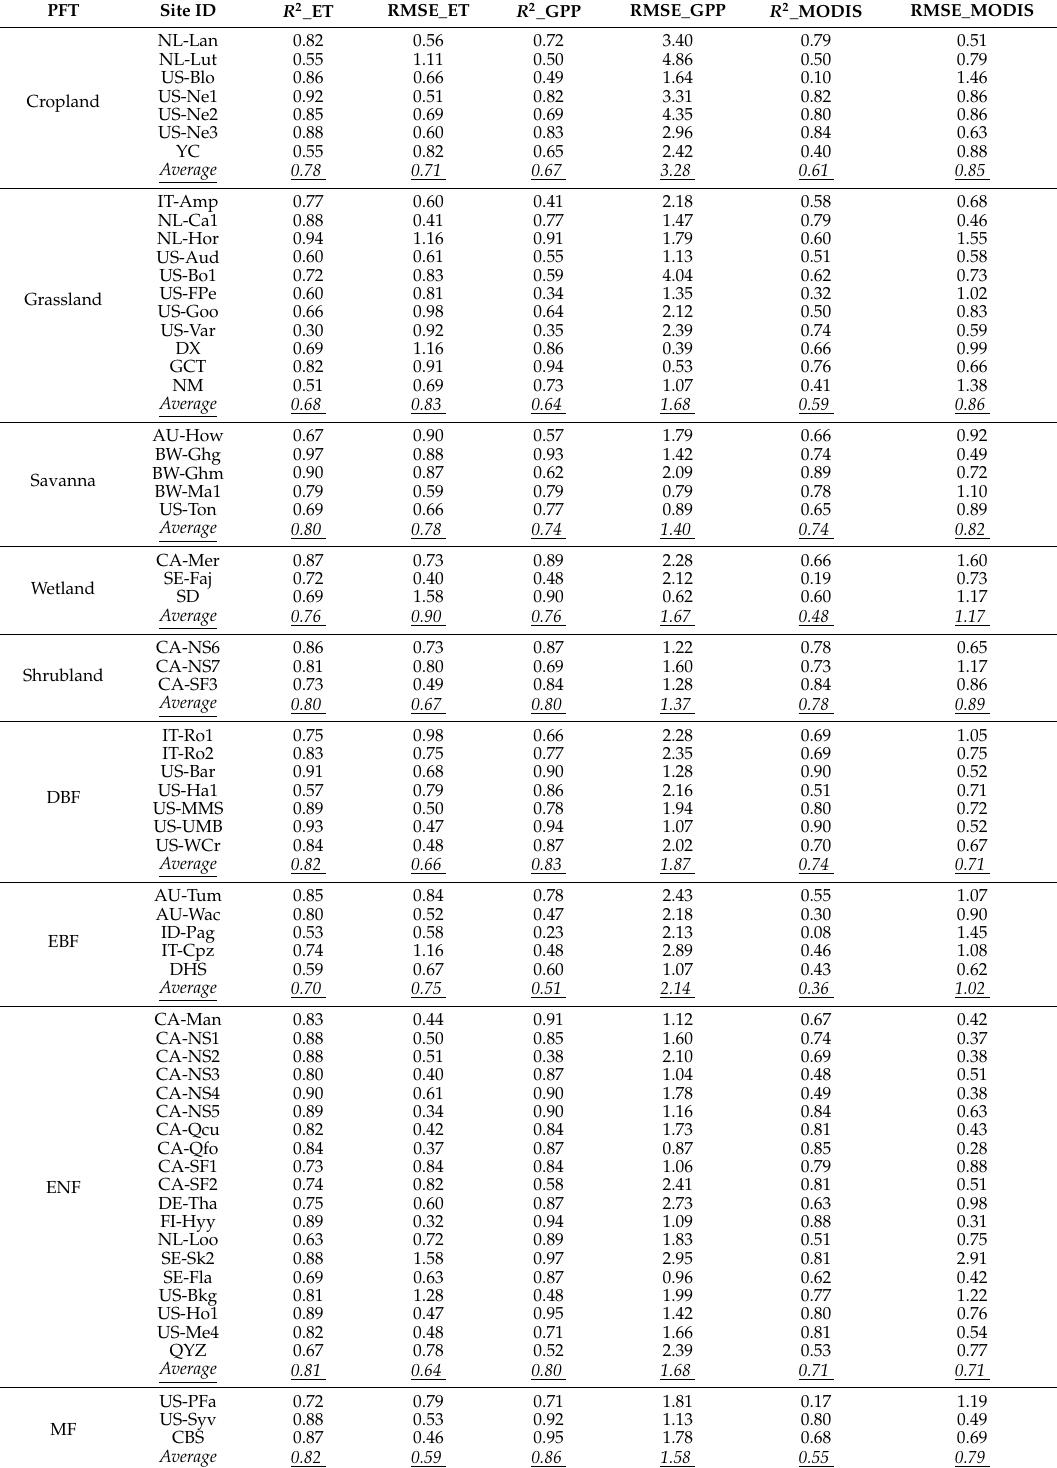
Table 3. Performances of the SWH and MODIS algorithms in ET and GPP prediction. R 2 _ET, R 2 _GPP and R 2 _MODIS are the R 2 of the relationships between ET modeled by SWH, GPP by SWH, MODIS ET and the observations, respectively. RMSE_ET (mm · day − 1 ), RMSE_GPP (g · C · m − 2 · day − 1 ) and RMSE_MODIS (mm · day − 1 ) are the root mean square errors between ET modeled by SWH, GPP by SWH, MODIS ET and the observations, respectively. PFT, plant functional